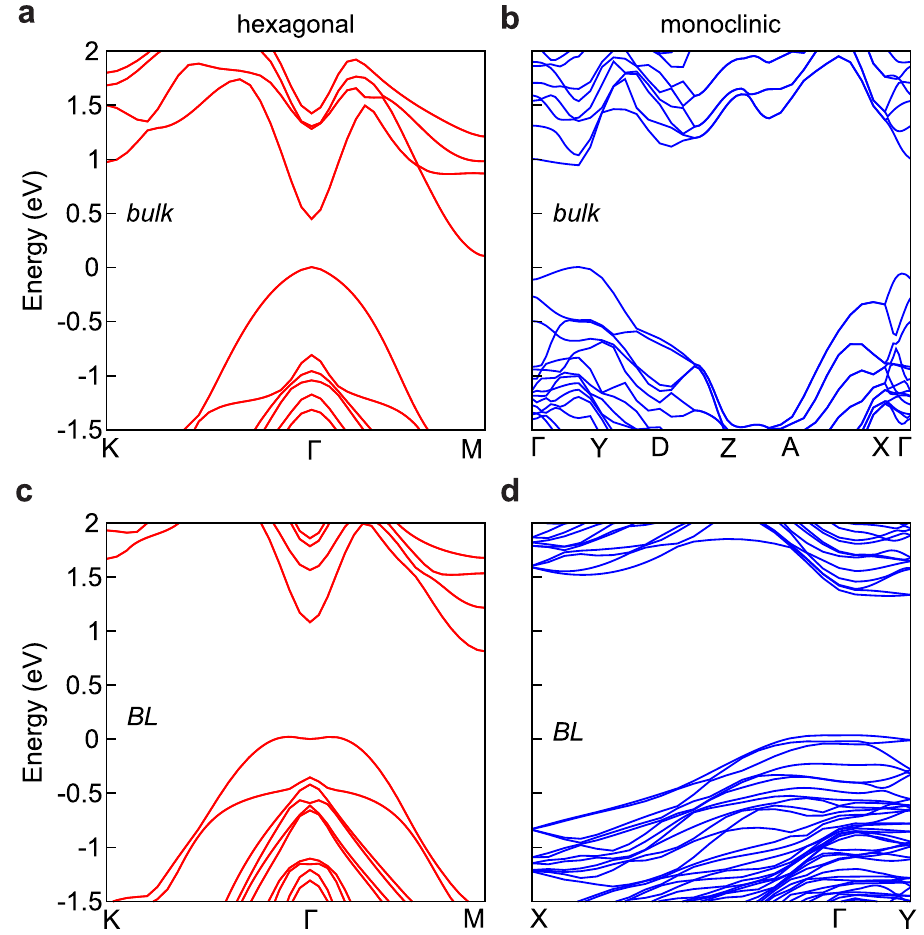
Fig. 4 Electronic band structures in GaTe. DFT band structures of h-GaTe ( a , c ) and m-GaTe ( b , d ) bulk and BL, respectively. For more details about the Brillouin zones and k -paths used see the Supplementary Fig. Figure 5a represents the Raman spectrum after rapid thermal annealing (RTA) of 18 ML h-GaTe. Both mode positions and numbers are in very well agreement with the m-GaTe crystal structure, as reported in ref. 14 . Differently to exfoliation 14,16,47 and physical vapour deposition methods 15,22 , the full width at half maximum (FWHM) of the two principal modes at 112.2 and 117.3